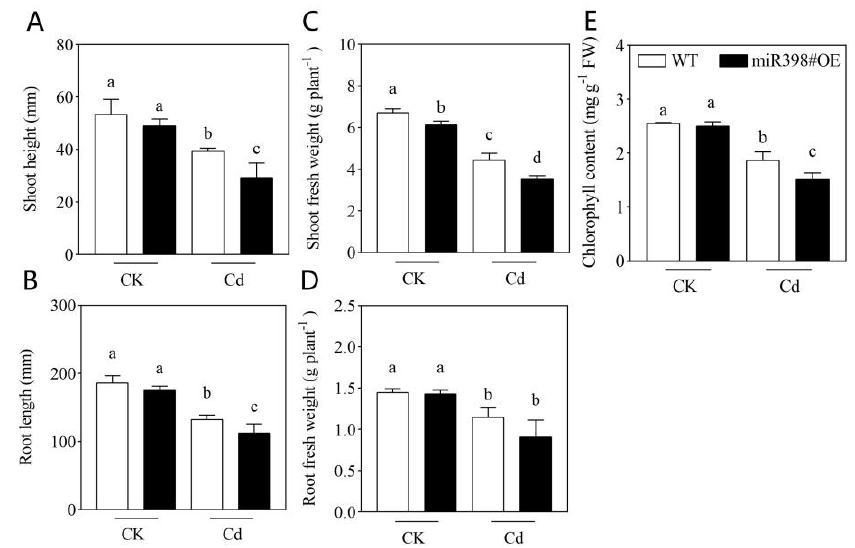
Figure 2. Effects of cadmium stress on tomato growth in wild type (WT) and transgenic line overexpressing MIR398 (miR398#OE). Shoot height ( A ), root length ( B ), fresh weight of the shoot ( C ) and root ( D ), and chlorophyll content ( E ). Tomato seedlings (25 d old) of WT and miR398 #OE were grown under control (CK) and 100 μM Cd(NO 3 ) 2 (Cd) for 9 d. The data are the mean values + SD of four individual replicates and different letters indicate significant differences ( p < 0.05). FW, fresh weight.